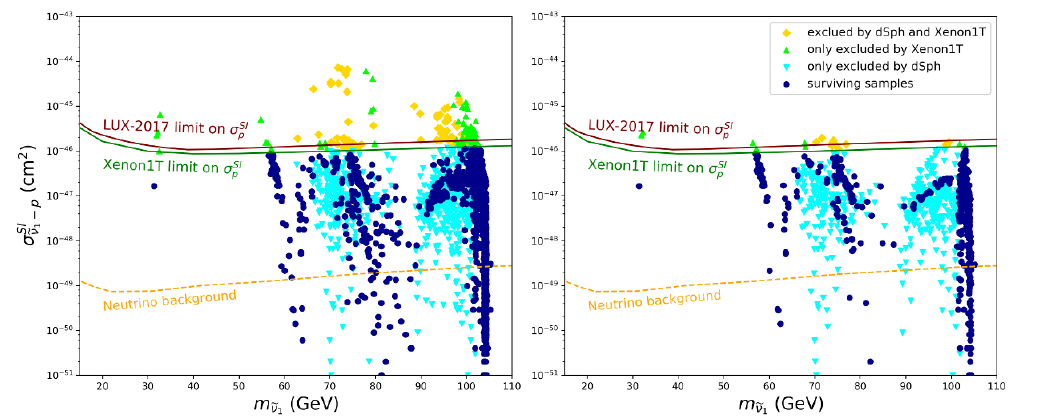
Figure 3 . Similar to the (cid:12)gure 2, but projected on (cid:27) SI